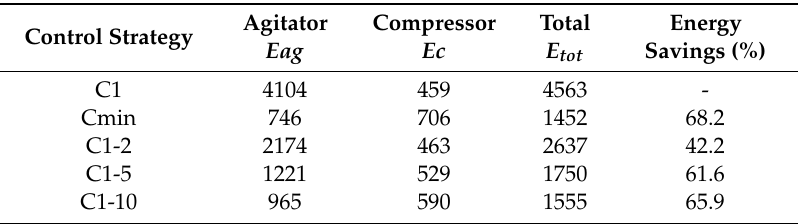
Table 1. Comparison of energy requirements (MJ) for the di ff erent strategies (set-point C OL = 2 mg L − 1 ). The % energy savings are relative to strategy